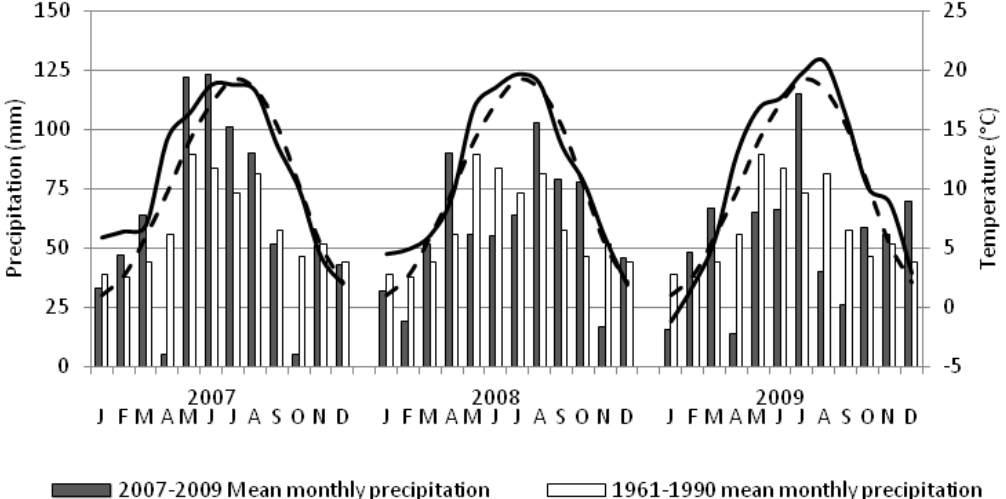
Figure 1. Climate data for Breisach Research Plot 2007 to